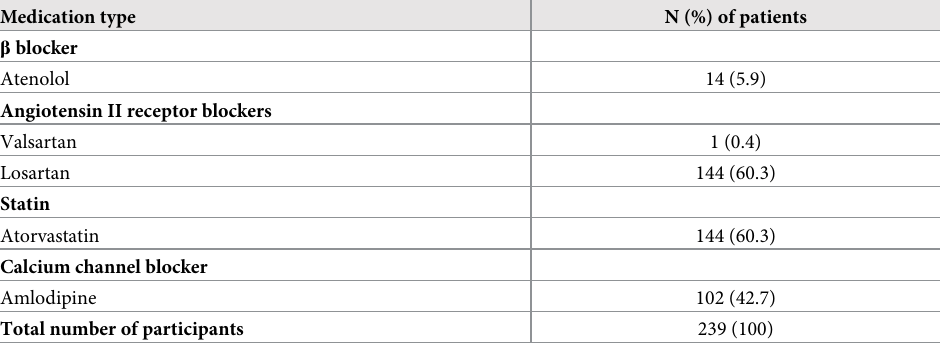
Table 2. Breakdown of prescribed CVD medications in the Kenyatta National Hospital cohort.